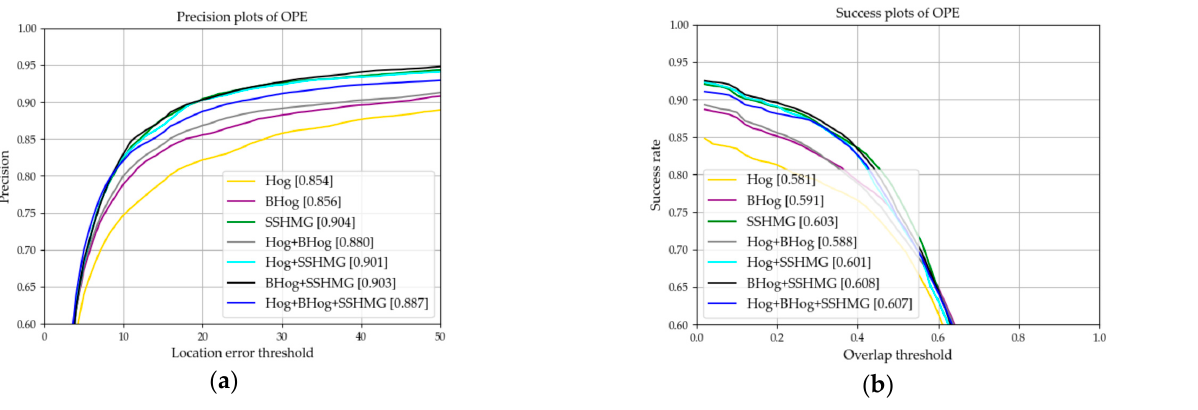
Figure 4. Performance of different feature extractors. ( a ) Precision plots of different feature extractors; ( b ) Success plots of different feature extractors. Table 2. Tracking performance comparison of feature extractors. The best two results are marked with red and